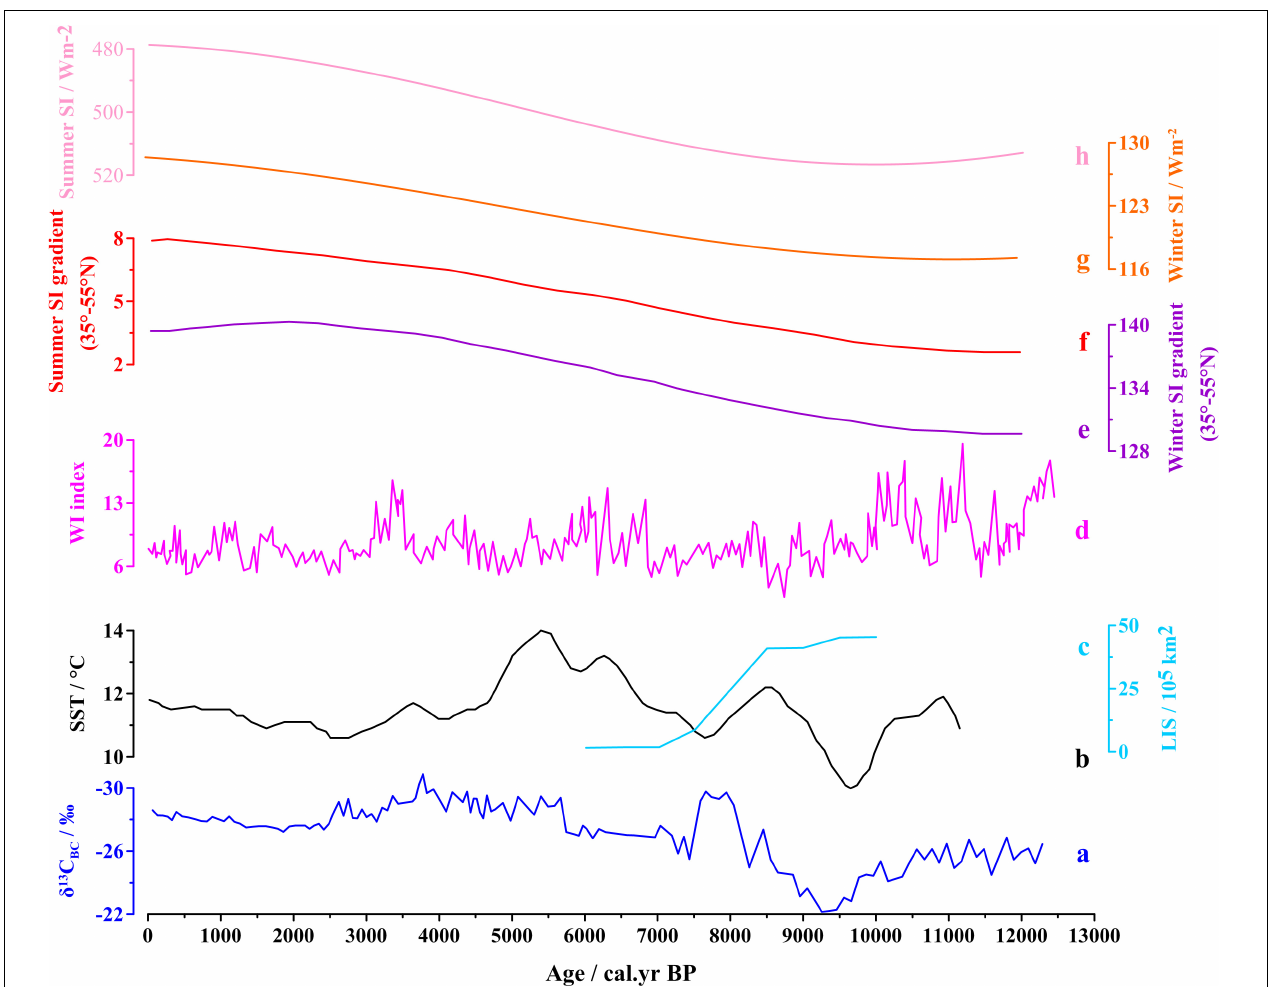
FIGURE 3 | Possible forcing for Holocene precipitation changes in northwest China. (a) Black carbon isotope record from Sayram Lake (This study). (b) Holocene sea surface temperature (SST) of North Atlantic (Berner et al., 2008). (c) Substantial remnants of ice sheets in the Northern Hemisphere (Carlson et al., 2008). (d) Reconstruction of sunspot number in the past 11400 yr (Solanki et al., 2004). (e,f) Summer and winter solar insolation on 45 ◦ N (Berger and Loutre, 1991). (g,h) Summer and winter insolation gradient between middle and high latitudes (Routson et al.,